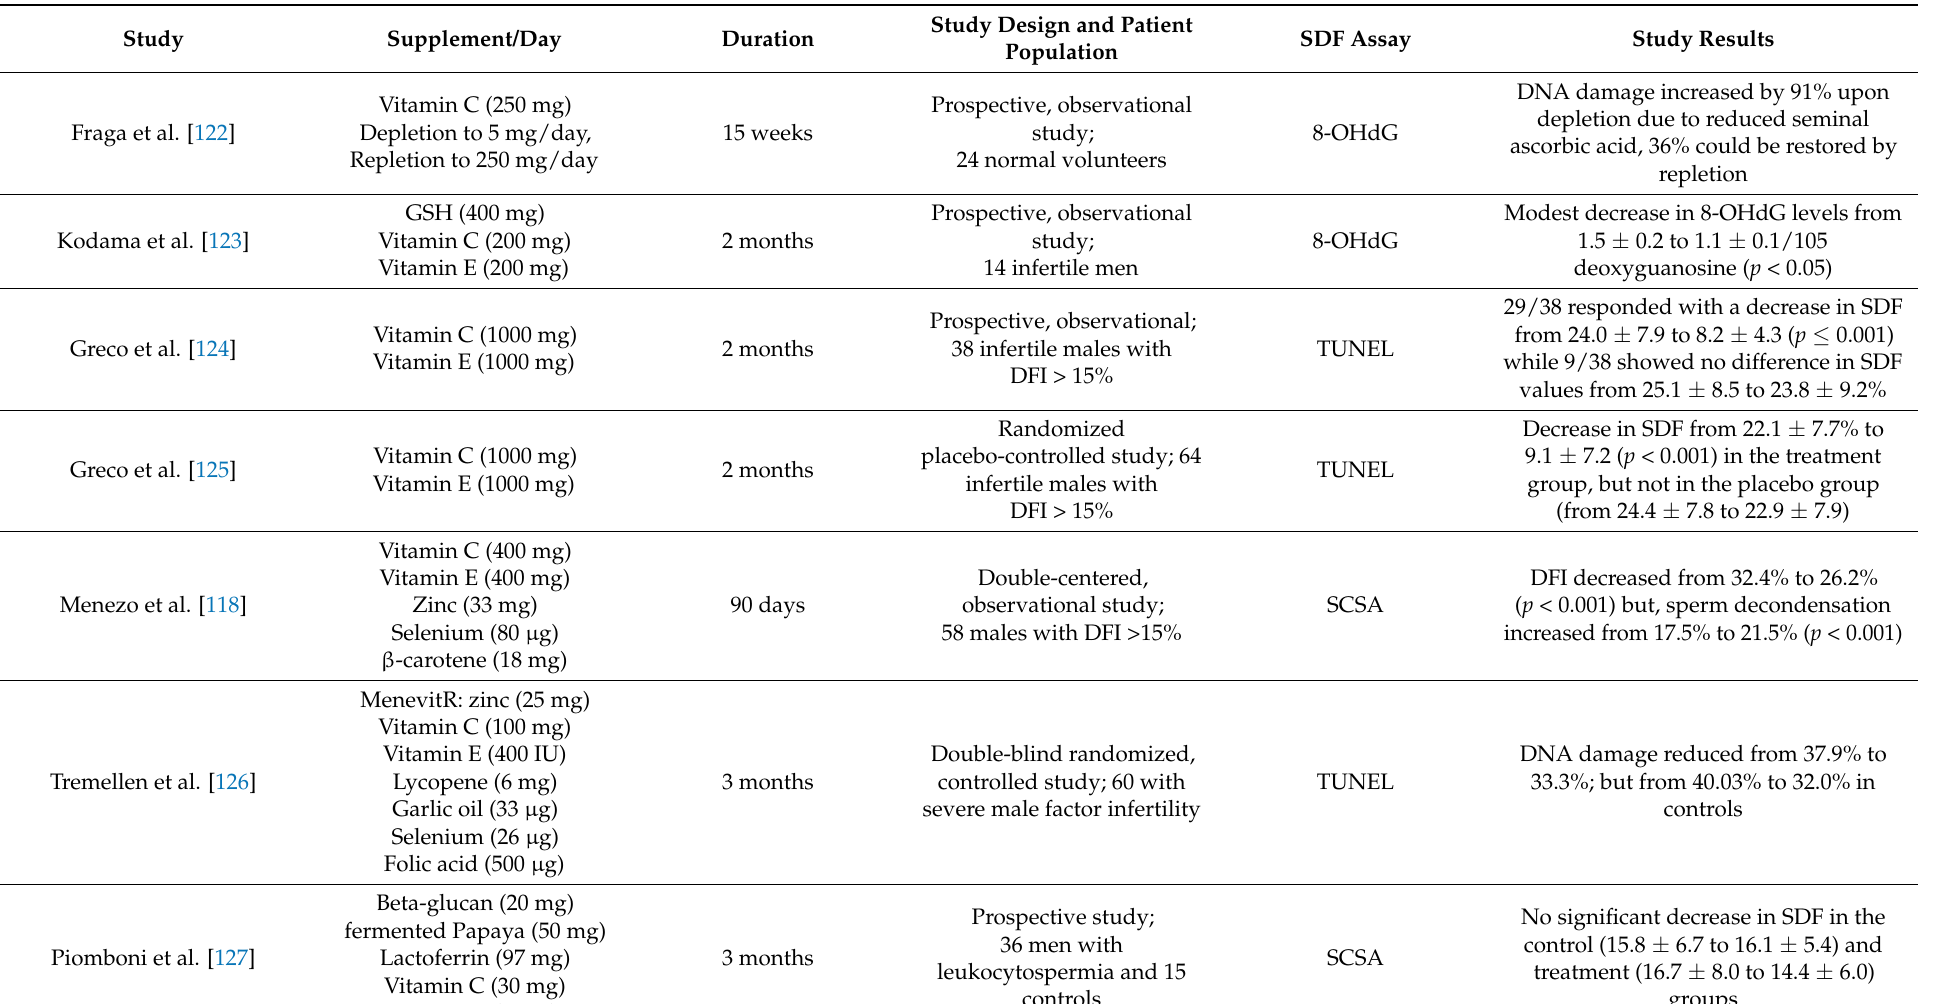
Table 7. Studies investigating the effect of oral supplementations on